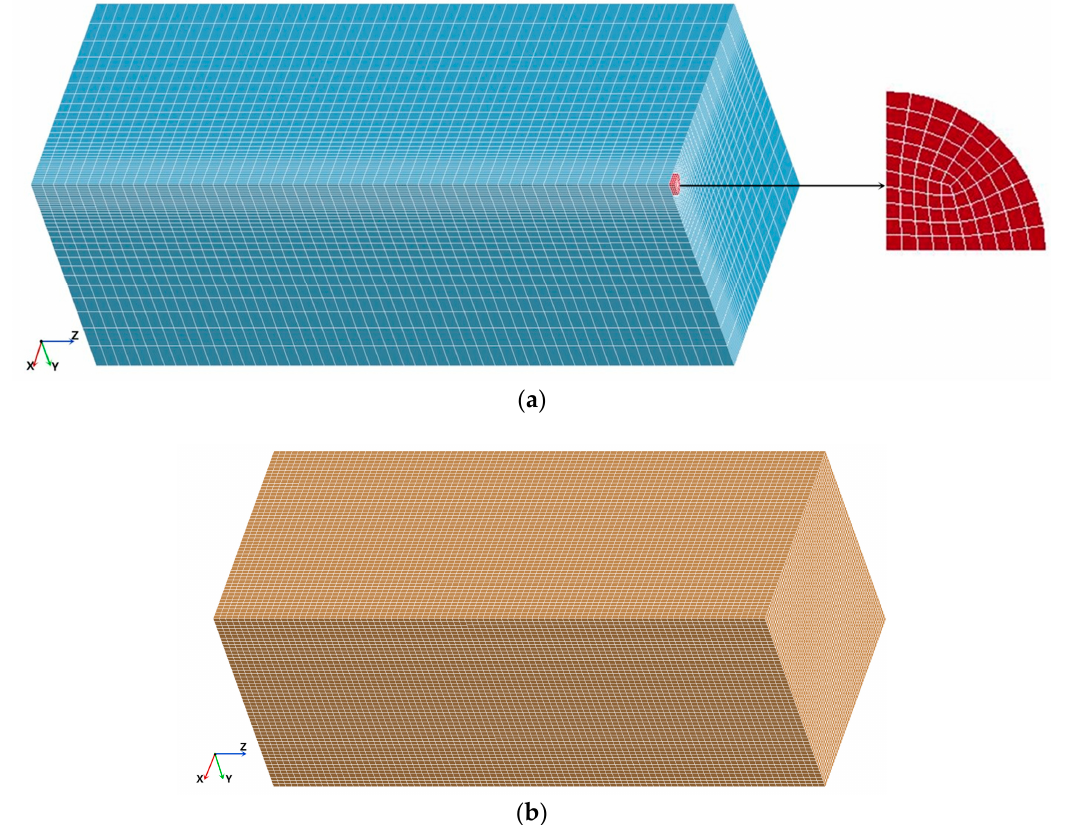
Figure 4. Model mesh of the jet source, water domain, and HBS. ( a ) Jet source and water domain; ( b ) the domain of HBS.